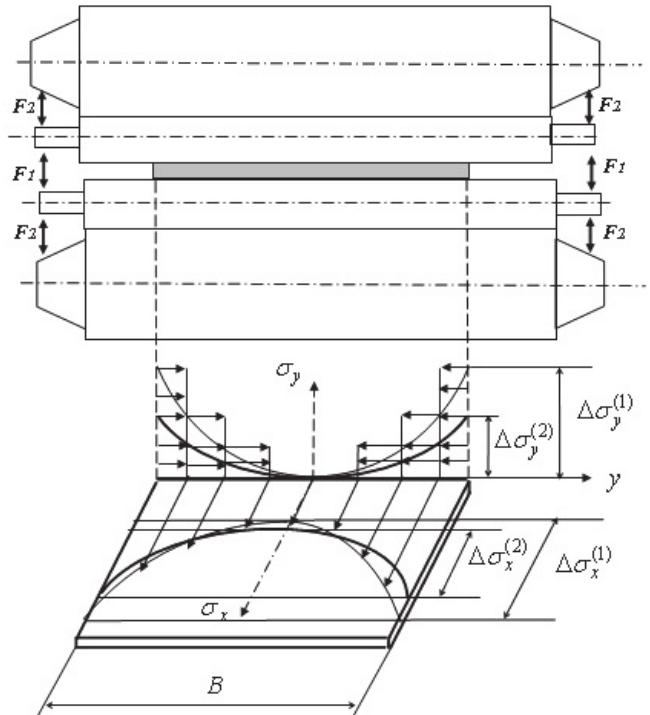
Figure 5: Impact of the work roll bending efforts on the distribution of specific tensions at the entrance and exit of deformation